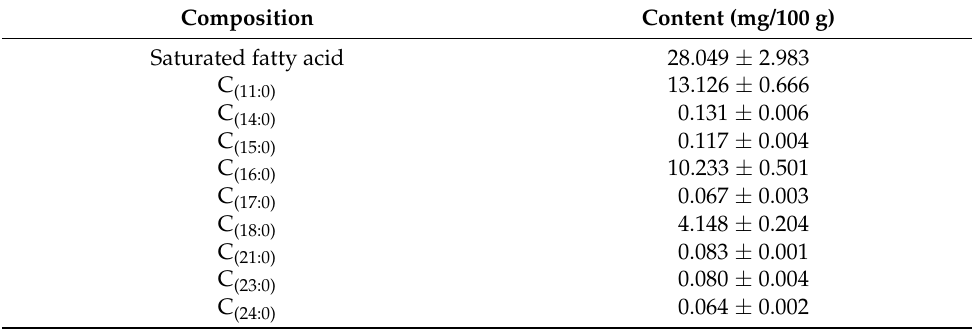
Table 1. Analyzed fatty acid composition of sea buckthorn